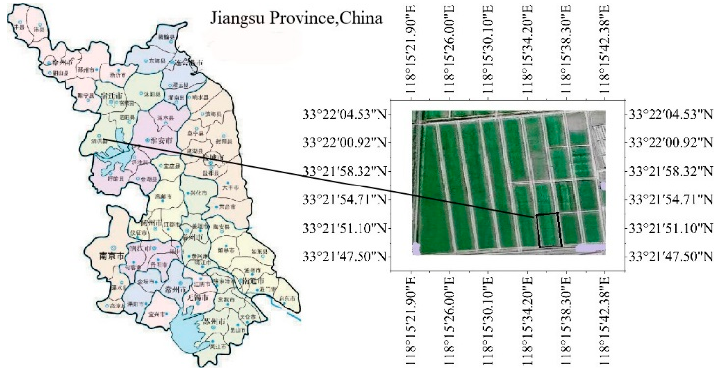
Figure 1. Experimental site.